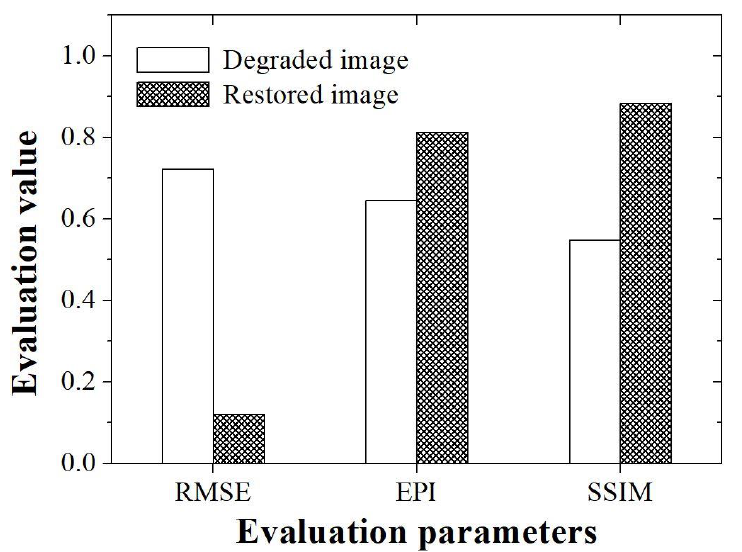
Figure 6. Graph of the evaluation parameters including the RMSE, EPI, and SSIM between the degraded and restored images.